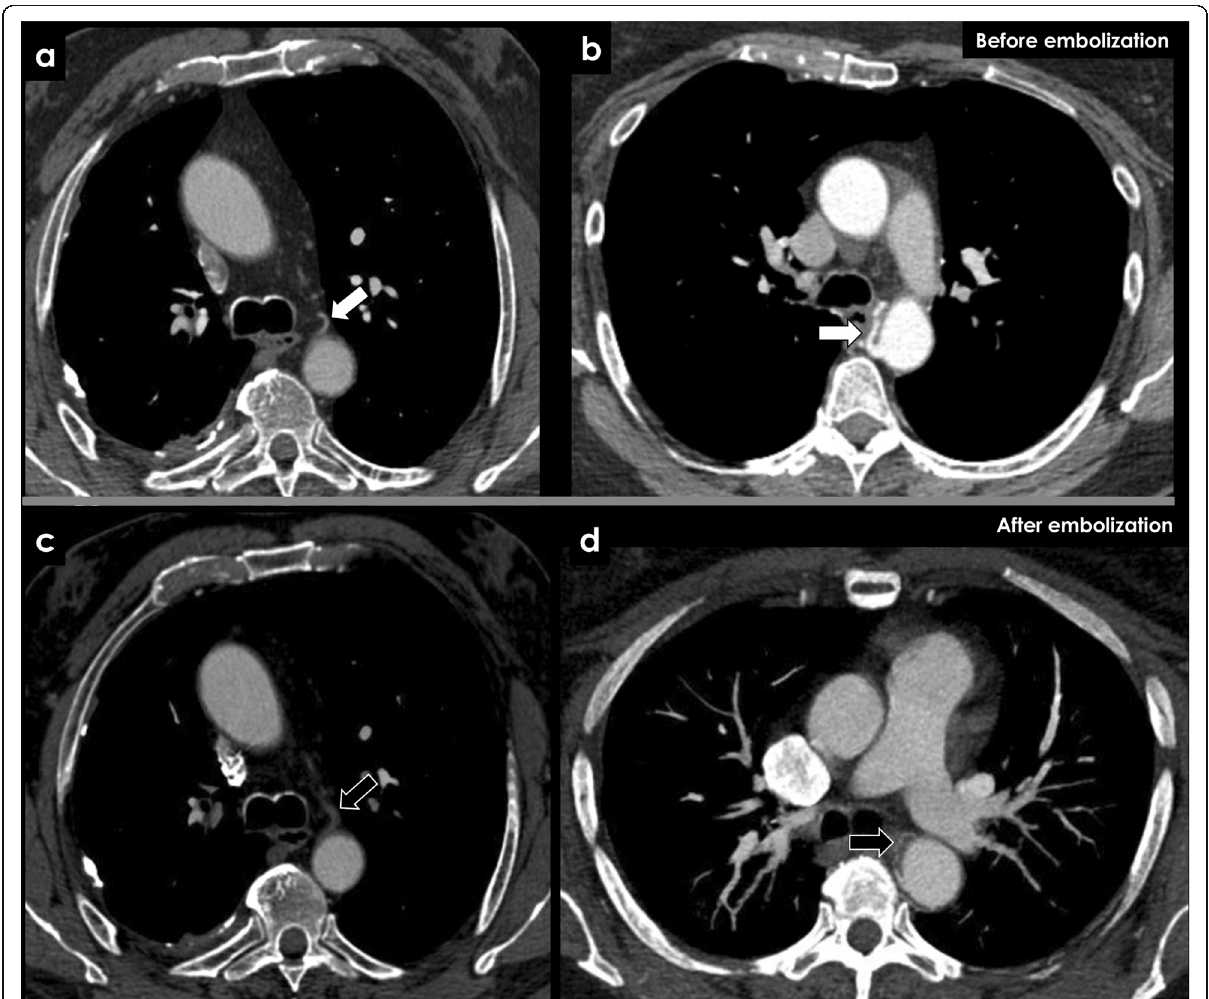
Fig. 14 CECT findings of bronchial arteries before and after embolization. After an effective bronchial artery embolization, absence of enhancement ( c , black arrow) and caliber reduction ( d , black arrow) are usual CECT findings. We can compare it to the imaging findings before the embolization ( a , b ; white